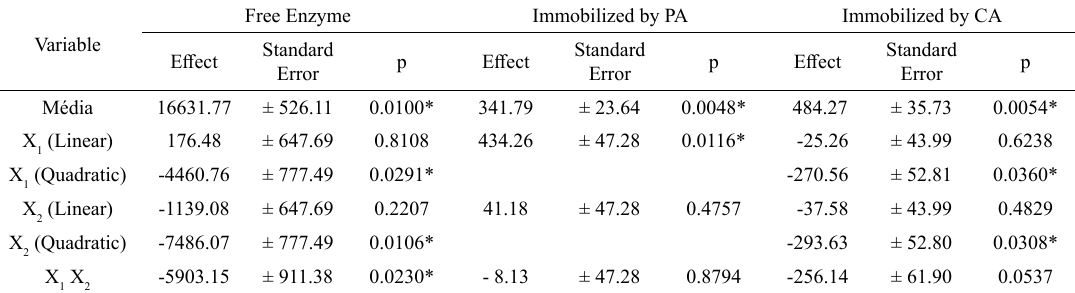
Table 3. Estimation of the effects of variables, standard error and the p value for the hydrolytic activity of free lipase and immobilized by PA and CA.